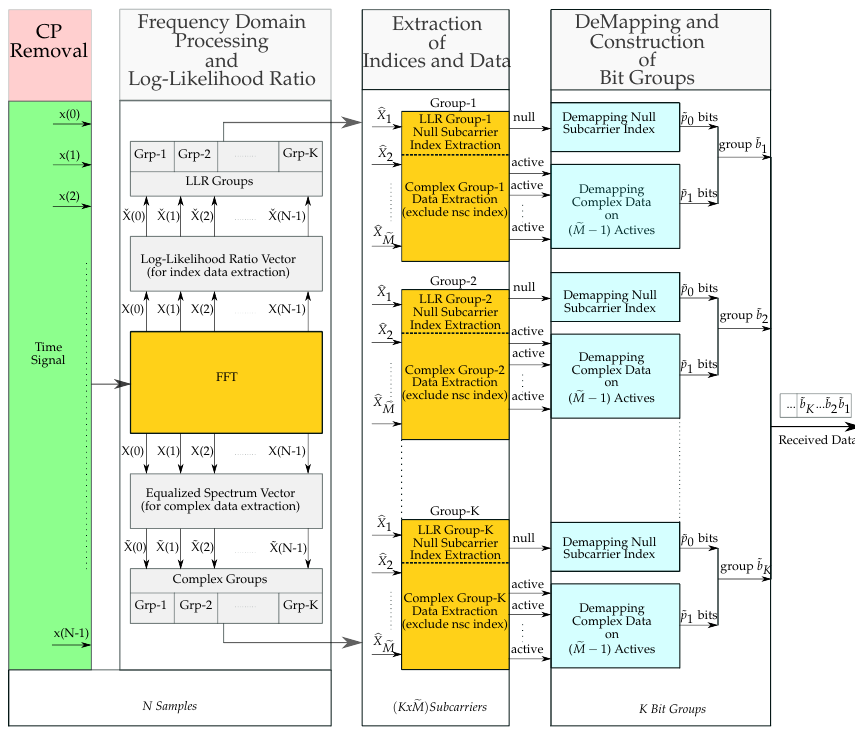
Figure 5. The proposed NSC-OFDM-IM